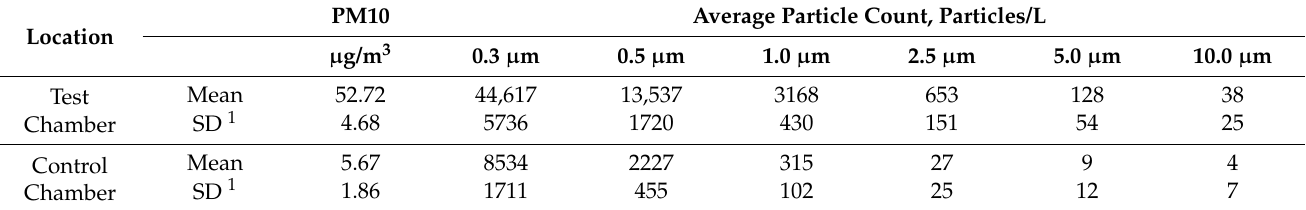
Table 1. Mean measured PM10 concentration and particle counts over 24-h period for test and control